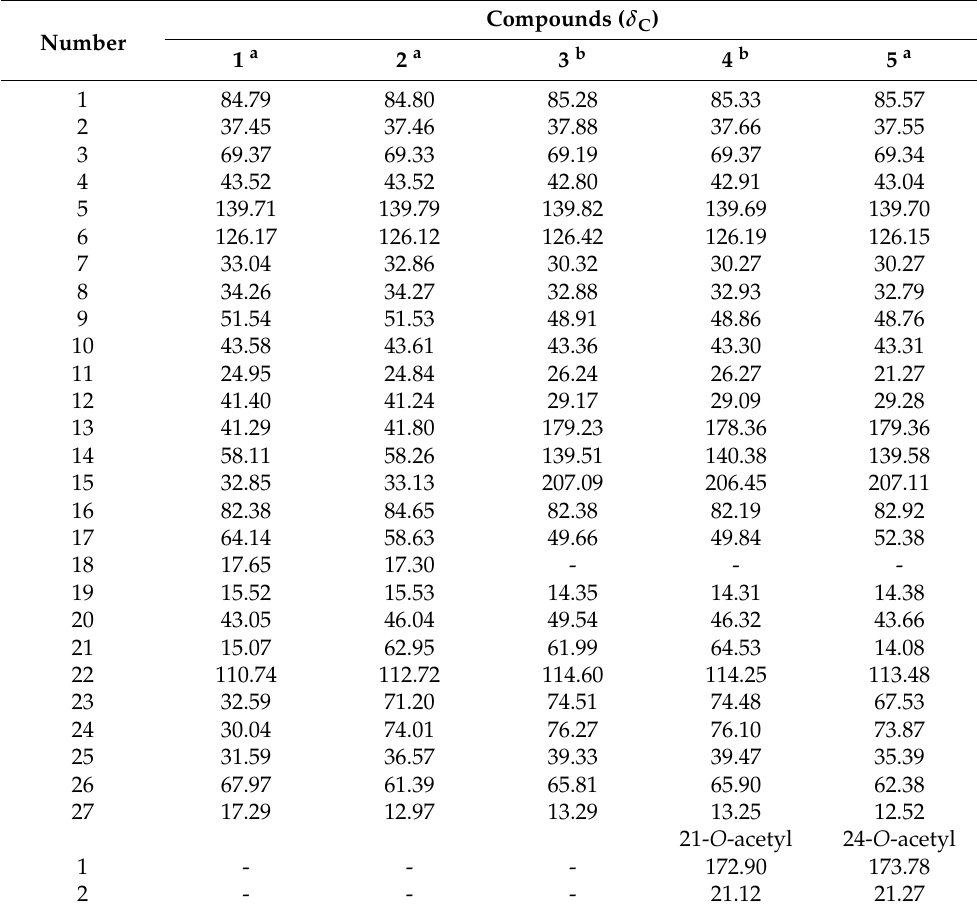
Table 1. 13 C-NMR data of aglycone moieties for compounds 1 – 5 in CD 3 OD.